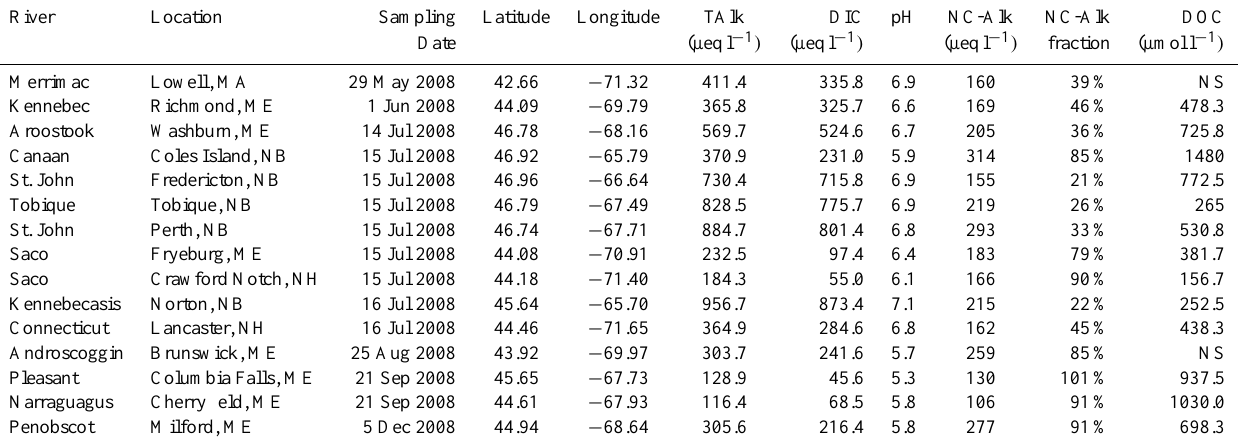
Table 2. Location information and NC-Alk data for northern New England and Canadian rivers. The NC-Alk fraction column lists the proportion of TAlk represented by NC-Alk for each river. NS in the DOC column indicates no DOC sample for that river.